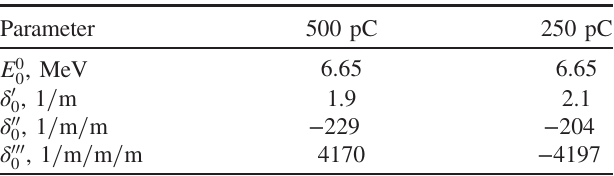
TABLE IV. The longitudinal phase space bunch parameters after the rf gun at distance z ¼ 3 . 2 m from the